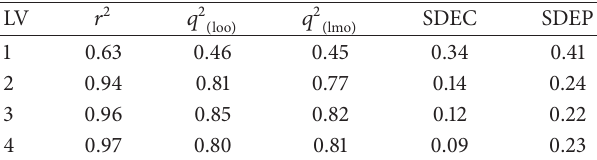
Figure 1: Plot of predicted versus experimental pIC 50 values for ALMOND model. Table 2: ALMOND-PLS results of the model developed for the series of 𝛽 -carboline alkaloids.